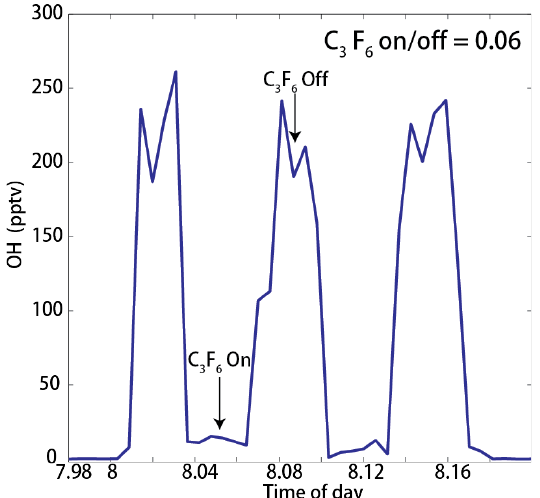
Fig. 2. Diurnal cycle of measured and modeled OH between 20 June and 30 July 2009 near the Blodgett Forest Research Sta- tion (BFRS). “OHwave” (blue line) is statistically different from “OHchem” (black line) and modeled OH (red line). The model in- corporates the current understanding of BVOC oxidation chemistry (see text for details). The vertical bars indicate OHchem’s absolute uncertainty of ± 45% (2 σ confidence), which comes from com- bining the uncertainty from the internally generated OH removed by the C 3 F 6 addition used to measure OHchem ( ± 20%) and the absolute uncertainty of the OH measurements ( ± 40% at 2 σ con- fidence). Note that OHchem here is corrected by 0.80 to account for the removal of internal OH by C 3 F 6 addition (see supplemental material). OHchem is similar to modeled OH, indicating a generally good understanding of oxidation in this forest atmosphere.